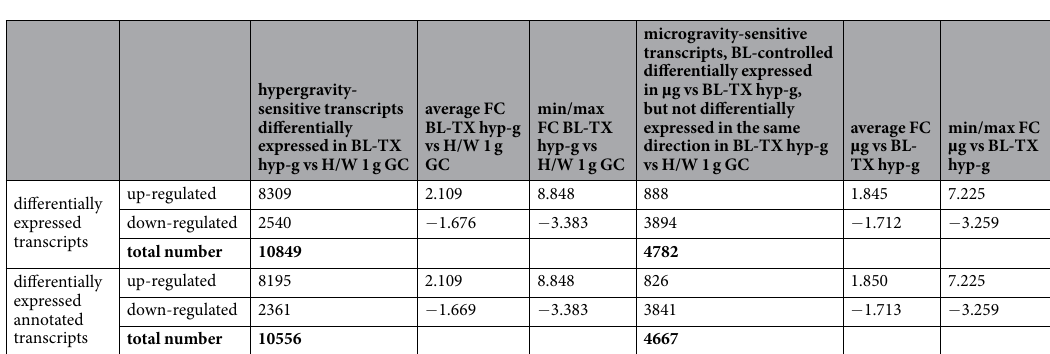
Table 5. Numbers of transcripts that are differentially expressed in response to altered gravitational conditions in the TEXUS-49 suborbital ballistic rocket campaign. Transcripts which were significantly changed in the control comparisons were eliminated. Differential expression is defined as t-test p-value < 0.05; fold change (FC) ≤ − 1.3 or ≥+ 1.3. FCs are ratios between the averages of linear expression values. If the ratio is < 1, FC is calculated as the negative reciprocal of the